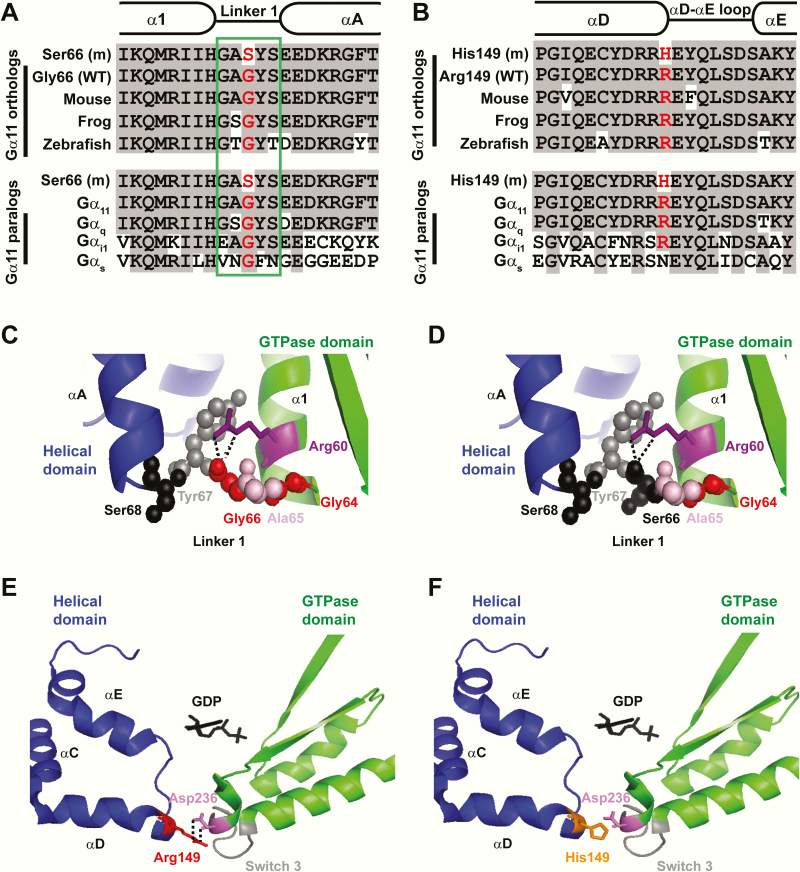
Predicted effects of the p.Gly66Ser and p.Arg149His mutations on the Gα 11 protein by analysis of evolutionary conservation and structural modeling. (A-B) Multiple protein sequence alignment of Gα 11-subunit orthologs (top) and Gα-subunit paralogs (bottom), with residues comprising the α1 helix, linker 1 peptide (green box) and αA helix shown in A; and residues of the αD helix, αD-αE loop, and αE helix shown in (B). Conserved residues are shown in gray, and WT and mutant (m) residue in red in panels A and B. Gly66 and Arg149 are highly conserved in Gα 11 orthologs and Gα paralogs. (C-D) Homology model of the Gα 11 protein based on the structure of Gα q in complex with an inhibitor (PDB: 3AH8) (25). (C) The WT Gly66, which is a nonpolar hydrophobic amino acid, is located within linker 1 and forms a contact with Arg60 (purple), which is a positively charged hydrophilic amino acid. (D) Mutation of Gly66 to serine (Ser66), a hydrophilic amino acid leads to the introduction of a polar side chain, which projects into the cytoplasm and may alter the tight packing of the linker 1 region. The contact between Arg60 and Ser66 is unaffected. (E-F) Homology model of Gα 11 based on the structure of Gα q in complex with the phospholipase C β3 protein (PDB: 3OHM) (26). (E) The WT Arg149 is located within the αD helix of the helical domain, and forms polar contacts (hatched line) with the Asp236 residue in switch 3. (F) Mutation of Arg149 to His149, likely causes loss of the polar contact with Asp236, and may affect the interaction of the αD-helix with switch 3.